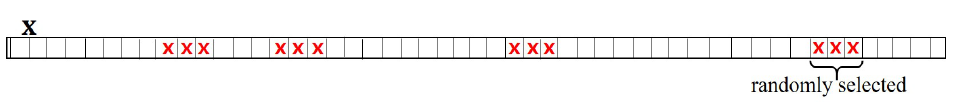
Figure 7. Example of training dataset when missing interval is three. Table 1. Heuristically-optimized k and s for each missing length in the first dataset. Missing